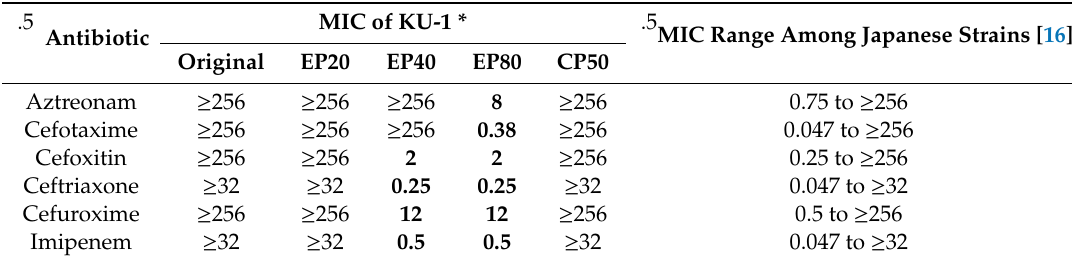
Table 2. Minimum inhibitory concentration (MIC) (µg/mL) of Francisella tularensis KU-1 passaged variants.